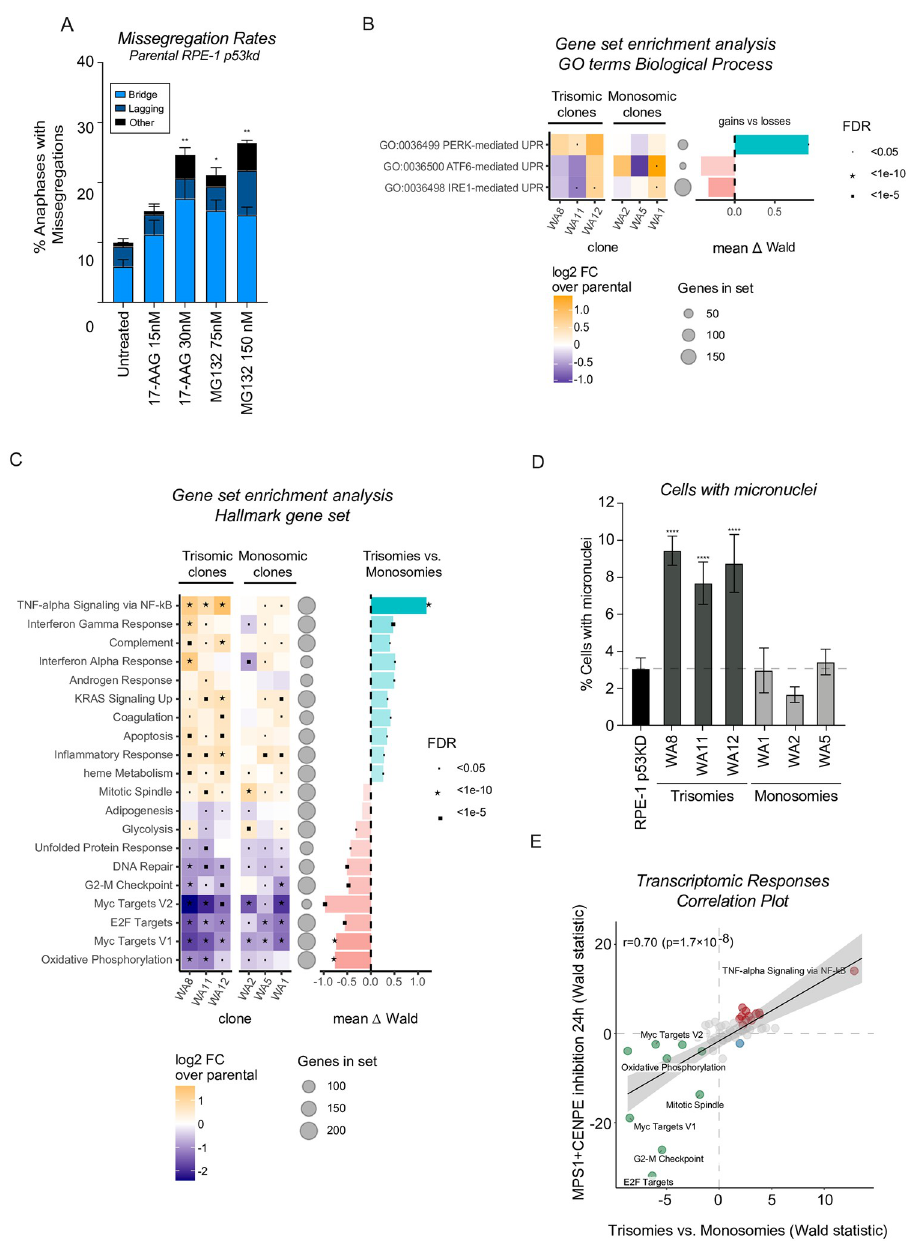
Fig 3. Different transcriptomic responses to trisomies and monosomies. A. Chromosome missegregation rates of RPE-1 parental p53KD cells untreated or treated with low doses of the indicated inhibitors for 24 hours determined as in Fig 1B. The experiment was performed in triplo and 50 cells were analyzed per condition per experiment. Error bars indicate standard deviation. B. Gene set enrichment analysis (GSEA) specifically for three different UPR branches, evaluating their up and downregulation in trisomic and monosomic clones compared to parental cells (left graph). Two replicates of every clone were sequenced and the Log2 fold change (FC) was determined compared to parental cells. The false discovery rates (FDR) are indicated with symbols. Differences between trisomies and monosomies were determined by Wald statistical testing. C. Gene set enrichment analysis (GSEA) of RNA sequencing data, evaluating up and downregulated hallmarks in trisomy clones and monosomy clones compared to parental (left graph). Two replicates of every clone were sequenced and the Log2 fold change (FC) was determined compared to parental cells. The false discovery rates (FDR) are indicate with symbols. Largest differences between trisomies and monosomies are shown on the right. Differences in hallmarks between trisomies and monosomies were determined by Wald statistical testing. D. Percentage of cells harboring micronuclei, as determined via snapshots from live-cell imaging data. 2 experiments were analyzed per clone, a minimum of 150 cells was analyzed per clone per experiment. Bars show